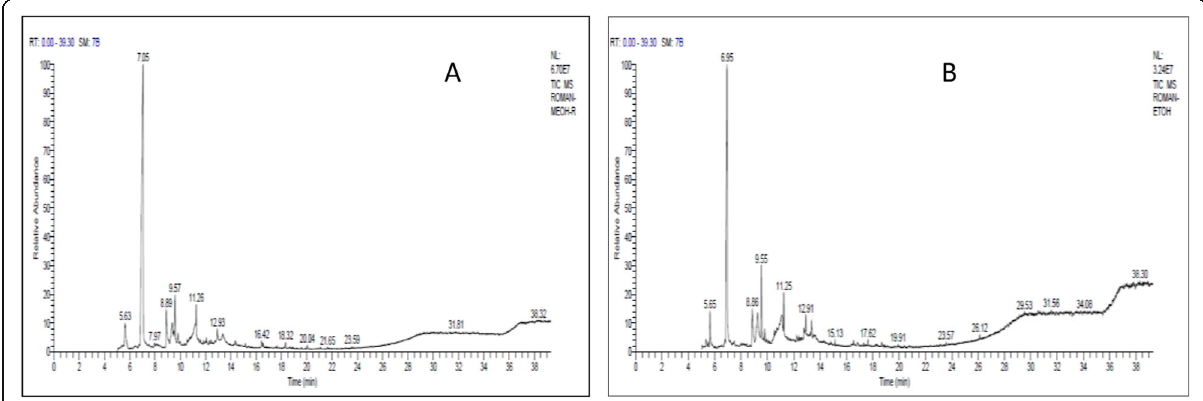
Fig. 4 GC-MS chromatogram of methanolic ( a ) and ethanolic ( b ) extracts of pomegranate